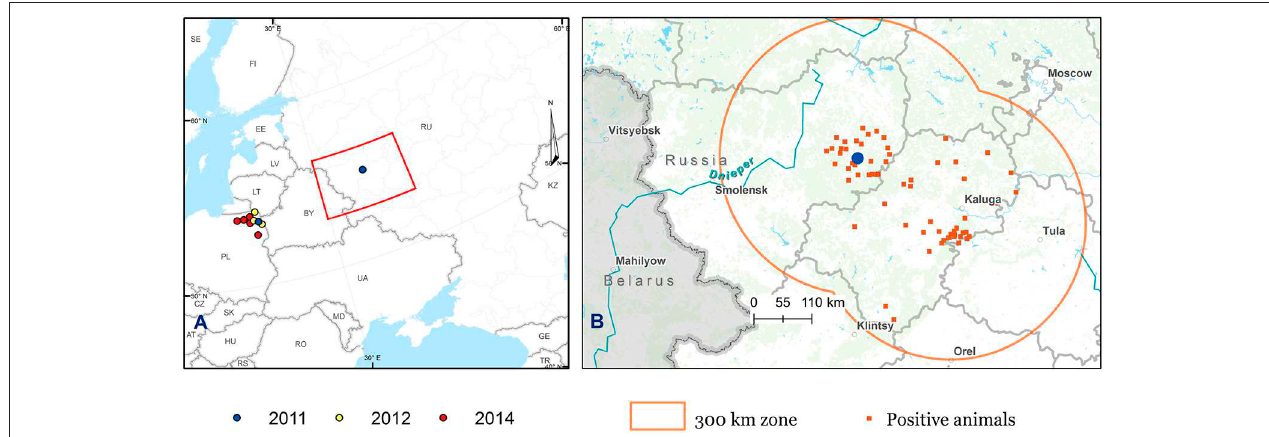
FIGURE 1 | Map showing the distribution of BTV-14 in Poland and Russia. (A) Map of the European part of Russia and Eastern Europe. (B) Map of the European part of Russia showing the areas of monitoring survey. The blue circles show the location of the site of the first case of BTV-14 in the Smolensk region, Russia (the farm “Smolensky Gallovei”) and the location of Łowczyki village, the site of the first case of BTV in Poland, both in 2011. The areas of monitoring survey (Smolensk and Kaluga regions) are marked in orange. The orange squares refer to farms with BTV-infected animals identified in 2011 and 2012. The BTV-14 cases identified in Poland in 2012 are indicated by yellow circles, while the red circles indicate BTV cases detected in Poland in